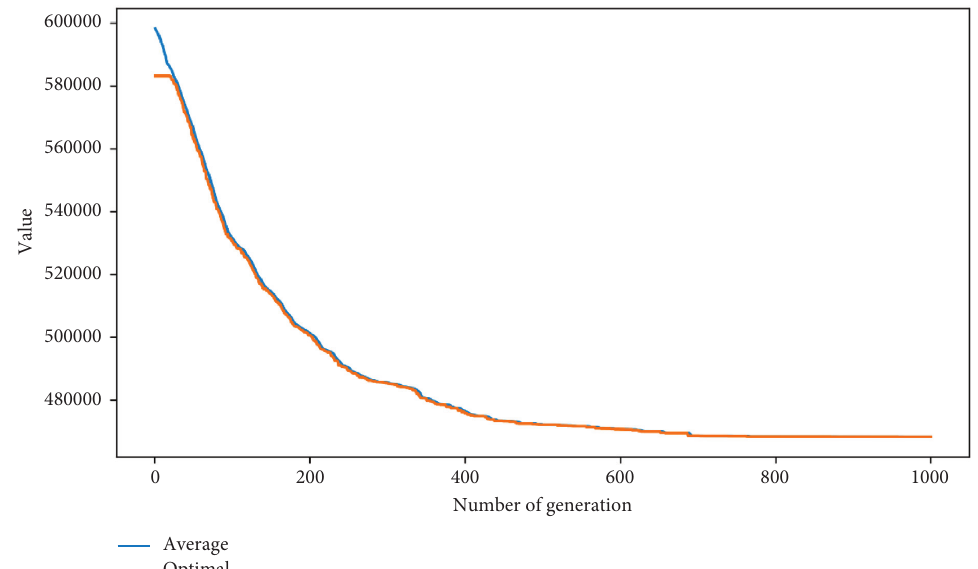
Figure 7: Schematic diagram of convergence process of 200